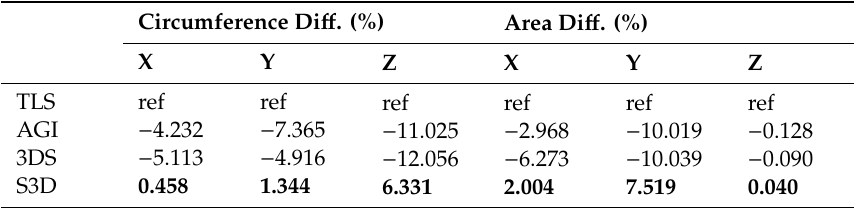
Table 11. Boulder No. 2: circumference and the section area—particular model di ff erences (in percent).